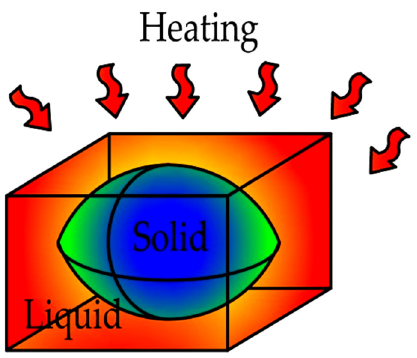
10 of 27 Figure 4. ( a ) Copper frameworks of the test specimens; ( b ) Cut shapes of the coke recyclate; ( c ) Finished test specimens with copper, PCM and the polymer matrix; ( d ) Finished test specimens with PCM and the polymer matrix.